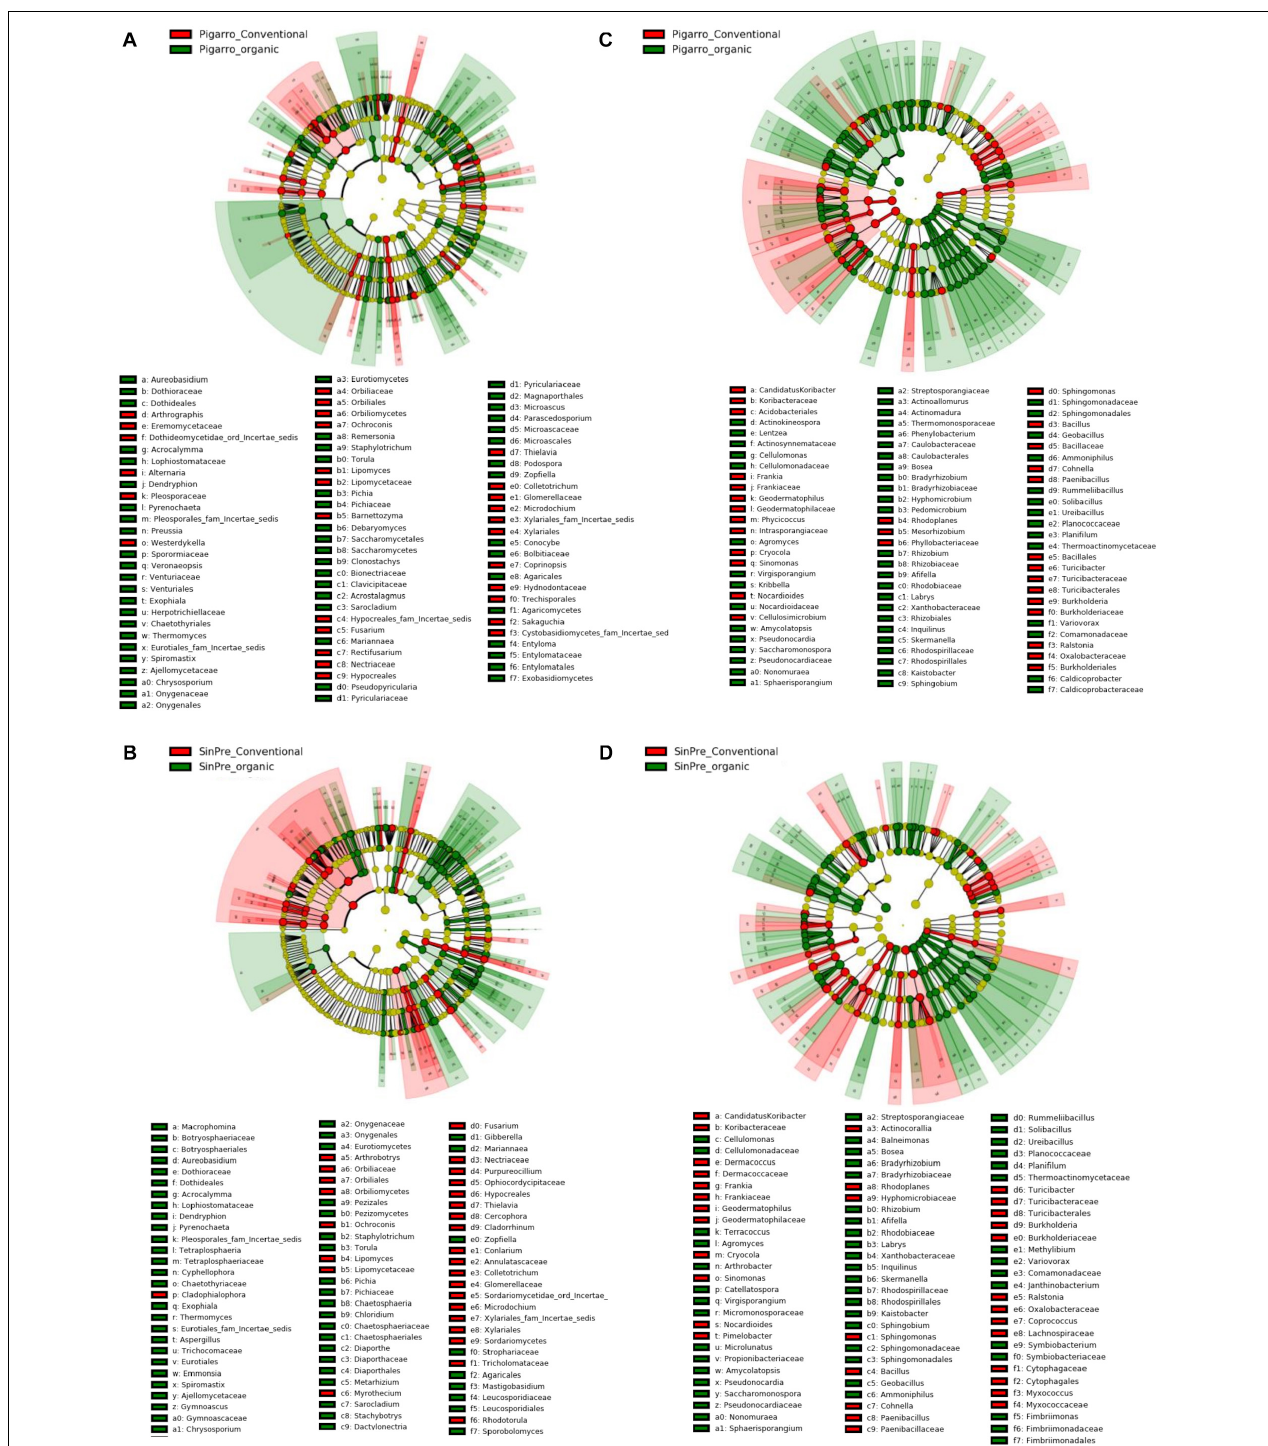
FIGURE 5 | Linear discriminant analysis (LDA) combined with effect size (LEfSe) was used to identify the most differentially abundant taxa among farming systems in the rhizosphere of maize. Cladogram generated by LEfSe indicating differences of fungi (A,B) and bacteria (C,D) at the phylum, class, family, and genus levels (relative abundance, ≤ 0.5%). Each successive circle represents a phylogenetic level. The red and green circles mean that conventional ( red ) and organic ( green ) showed differences in relative abundance; yellow circles mean non-significant differences. Differing taxa are listed on the right side of the cladogram . Bar graph showing the LDA scores for bacteria is represented in Supplementary Figure 1 . Only taxa meeting an LDA significant threshold > 2 are shown.